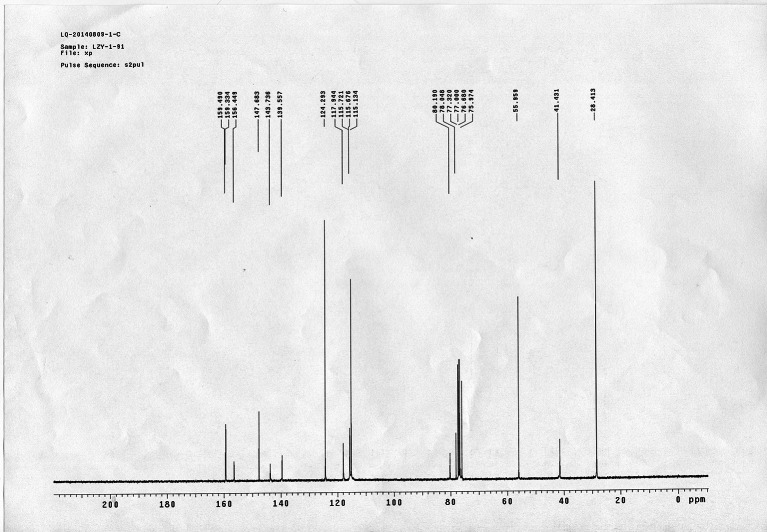
13C NMR spectra of compound 11.